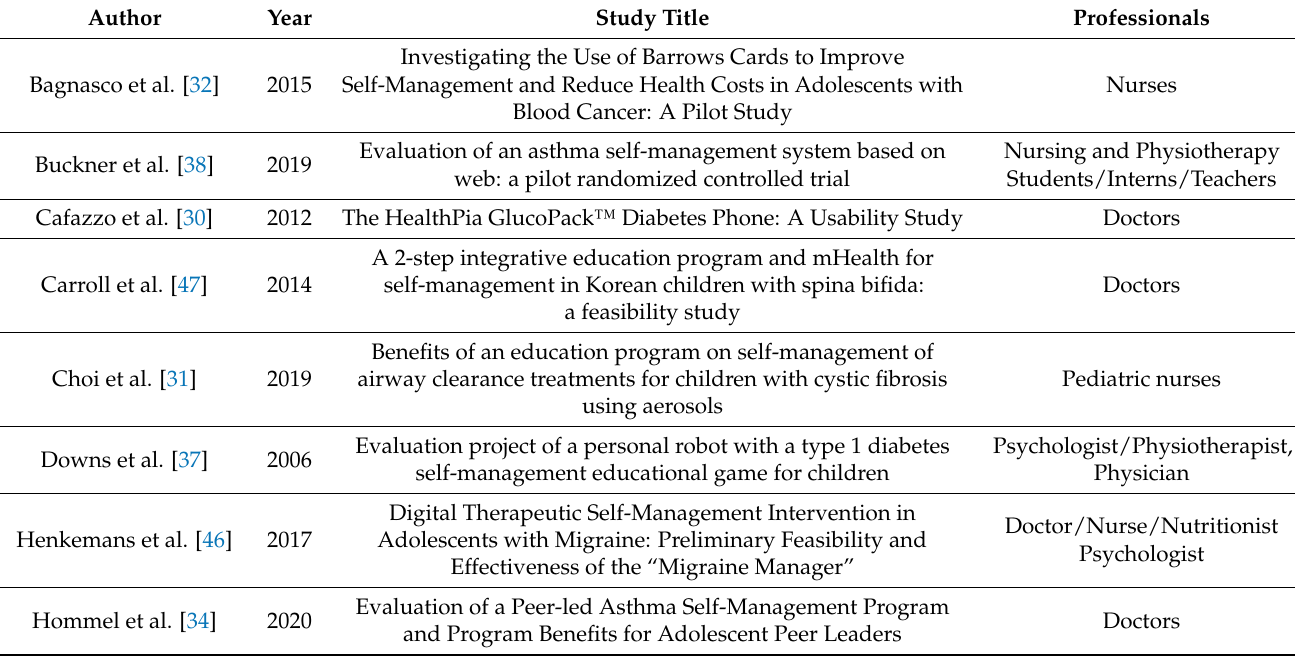
Table A7. Health professionals who promote self-management in children and